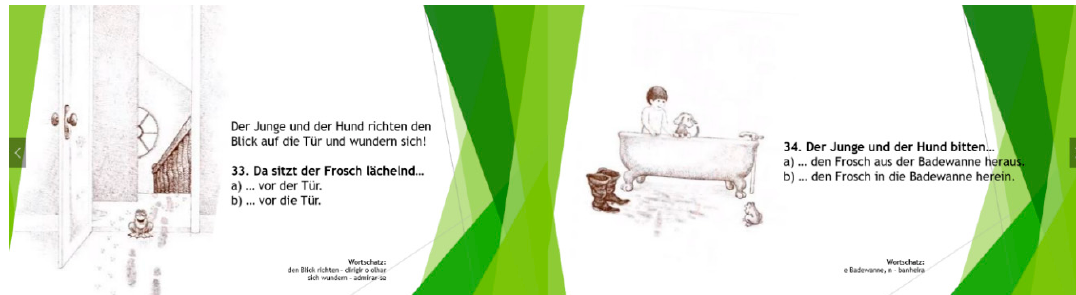
Figure A25. Pretest: Binary-choice recognition task.